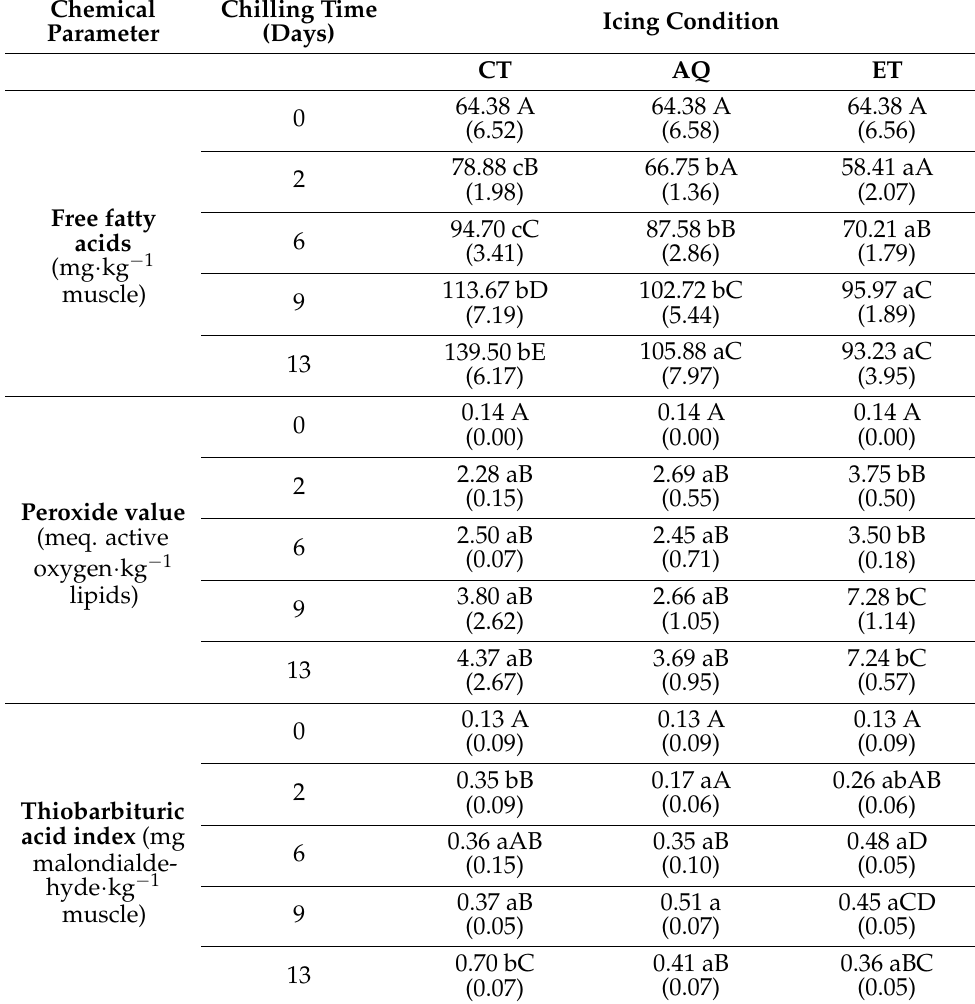
Table 3. Assessment of lipid damage * related to quality loss in chilled hake subjected to different icing conditions